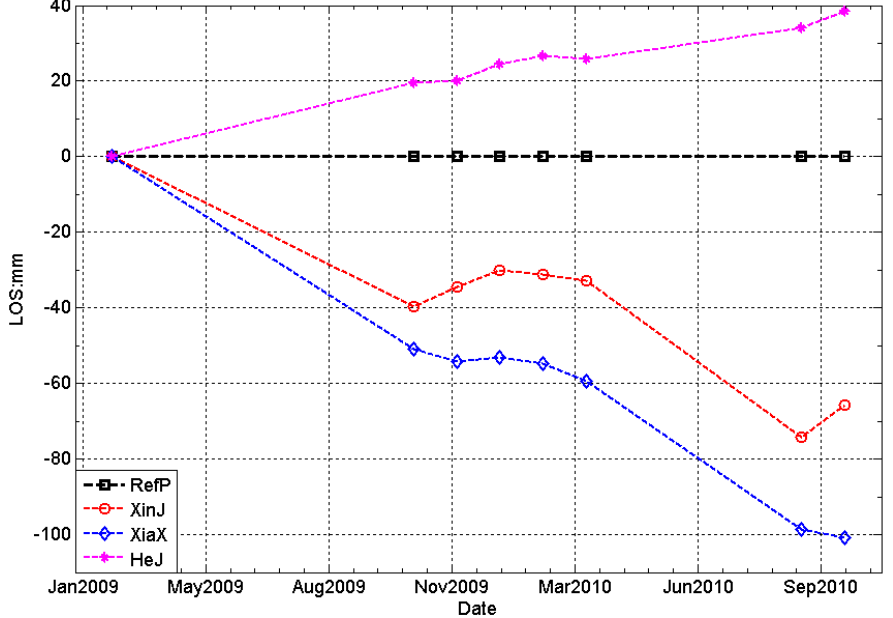
Figure 5. Cumulated subsidence curves. “RefP” is the reference point, “XinJ” is the town of Xinjiang, “XiaX” is the town of Xiaxian, and “HeJ” is the town of Hejin.